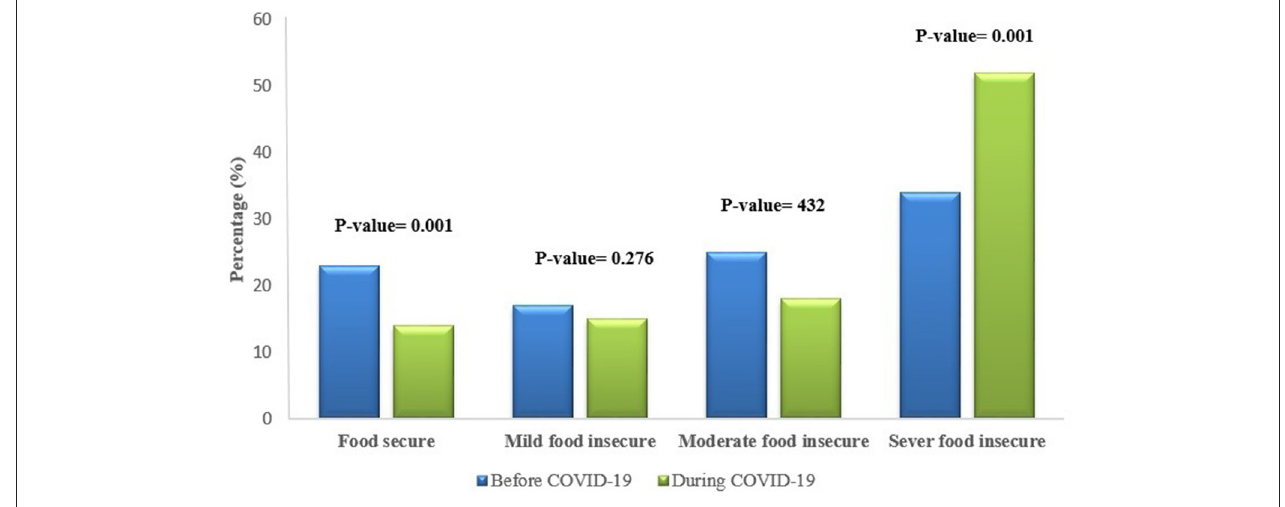
FIGURE 2 | Food security status of rural households before and during COVID-19.